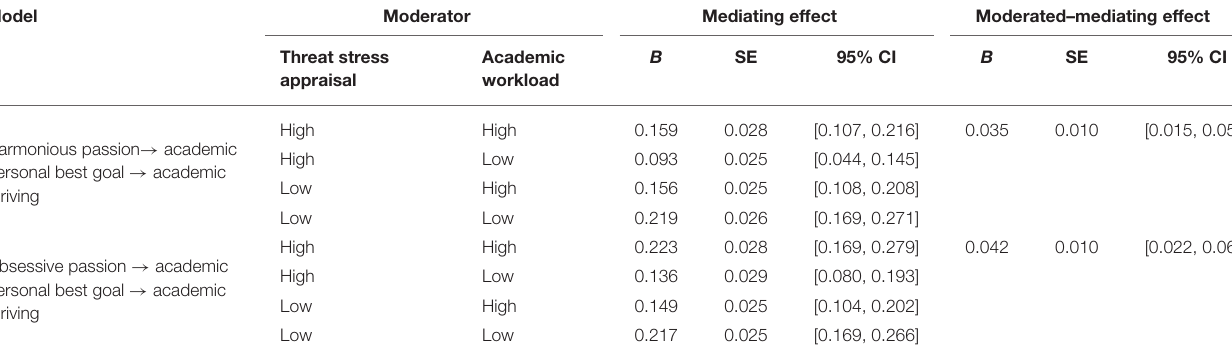
TABLE 4 | The joint moderated–mediating effect of academic workload and threat stress appraisal.